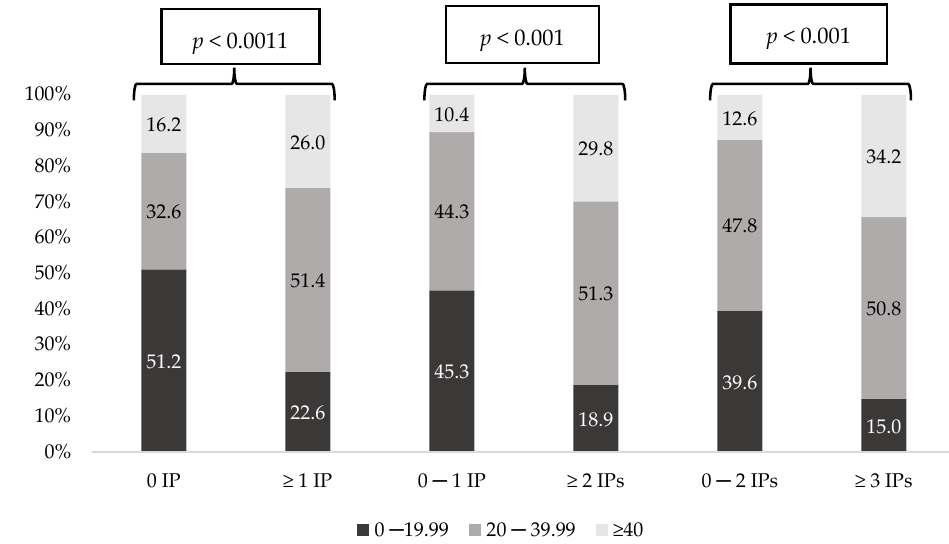
Figure 4. Prevalence of MRCI degree considering number of Inappropriate Prescriptions (IPs).